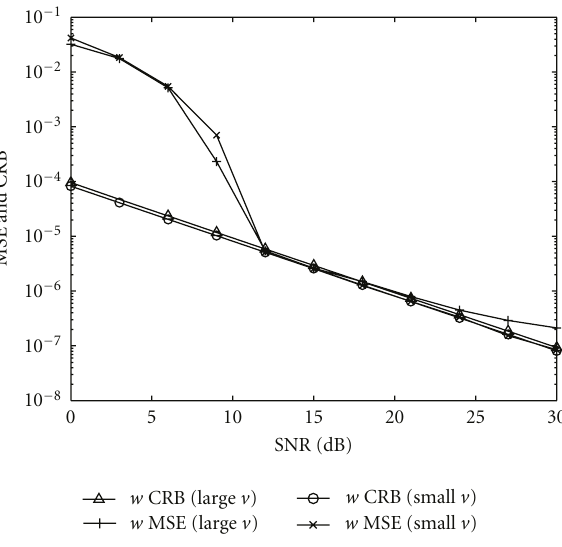
Figure 6: CFO estimation MSE versus SNR: N = 9.